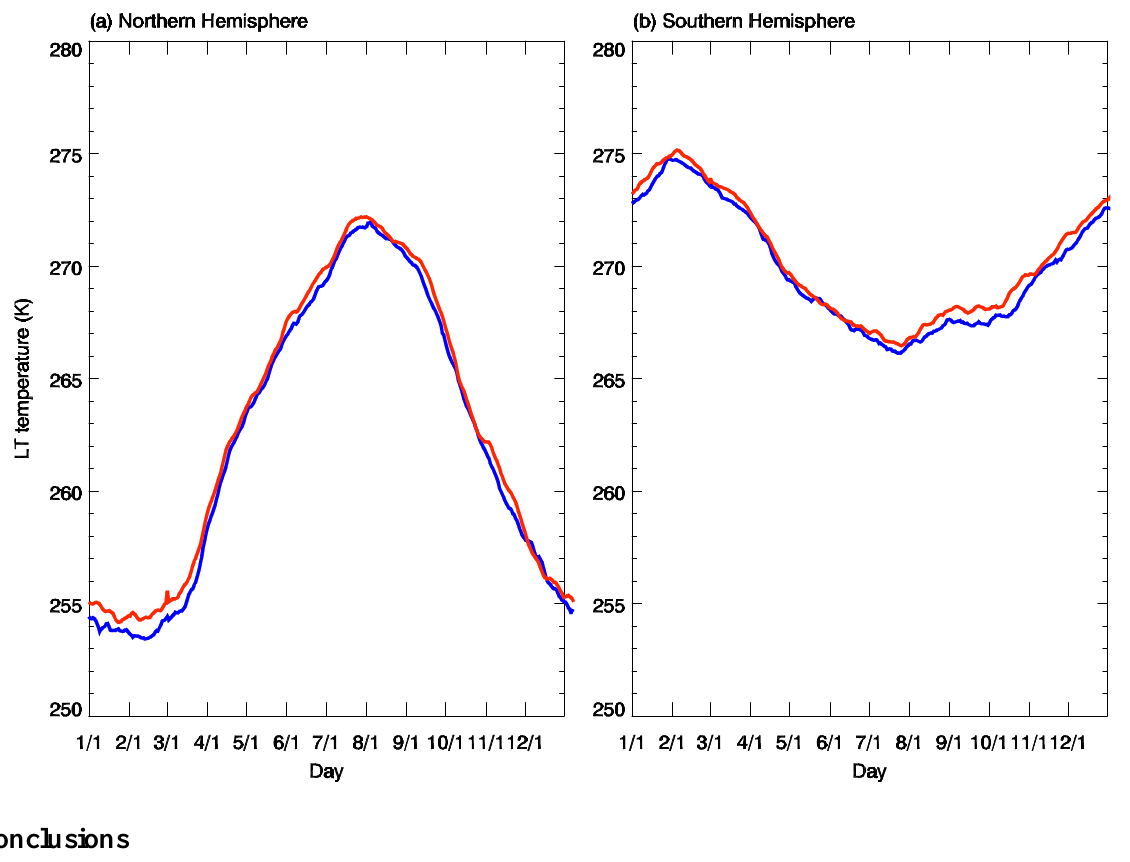
Figure 5. Same as Figure 4 except for 32.5° to